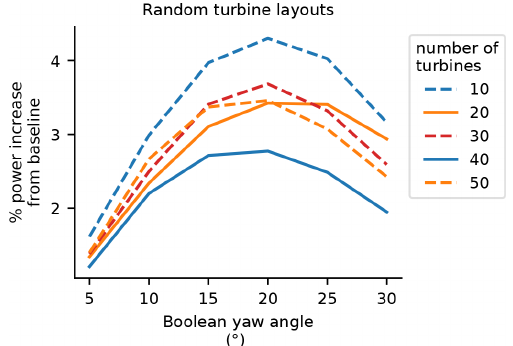
Figure 9. The absolute percent improvement over the nonyawed baseline for the Boolean optimization as a function of the Boolean yaw angle. The results shown are averaged for seven randomly gen- erated turbine layouts for the different numbers of turbines indicated on the x axis. Boolean yaw angles between 5 and 30 ◦ are